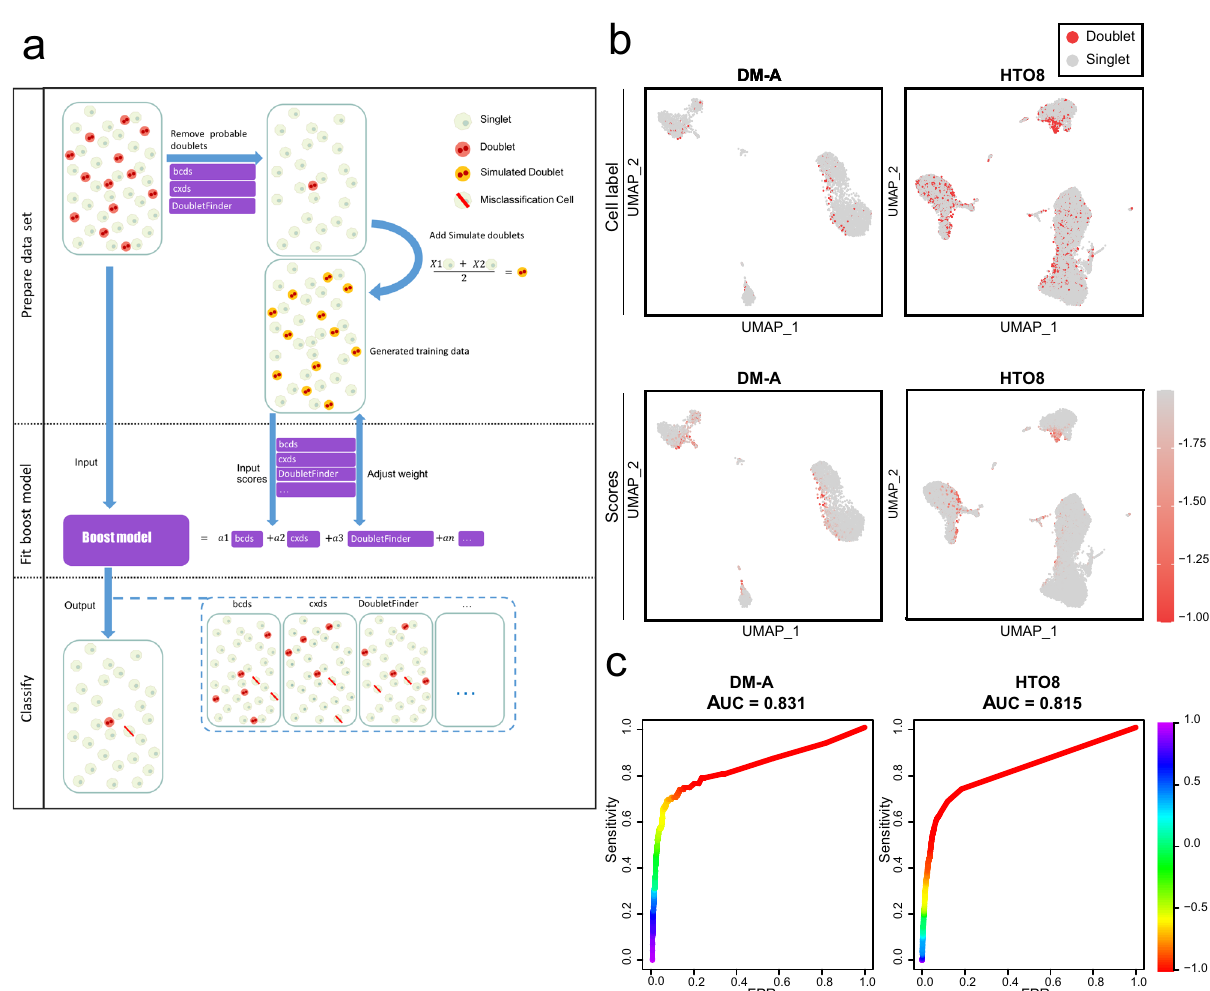
Fig. 1 Chord overview and its performance on the DM-A and HTO8 tests. a Schematic outline of the Chord work fl ow. First, preliminarily predicted doublets are fi ltered using bcds, cxds and DoubletFinder, and then the processed dataset is randomly sampled to generate simulation doublets that are added to the training dataset. The second step is to fi t the weights of the integrated methods through the GBM algorithm on the training dataset. In the third step, the ensemble model is used to evaluate the original expression matrix and the doublets are identi fi ed by the expectation threshold value. b UMAP was embedded for the DM-A and HTO8 tests with experimental doublet labels. The doublets are shown in red, and the singlets are shown in grey. The doublet prediction scores of Chord were visualised on the UMAP plots for the DM-A and HTO8 tests. The DM-A dataset was from human peripheral blood mononuclear cell (PBMC) samples using the experimental demuxlet method to annotate doublets 11 . The HTO8 dataset was from the samples of PBMC using eight barcoded antibodies to mark and label doublets 9 . c The ROC curves of Chord were drawn for the DM-A and HTO8 tests using the R package PRROC 29 . Table 1 Comprehensive performance of each method in real-world scRNA-seq datasets with experimentally annotated doublets.